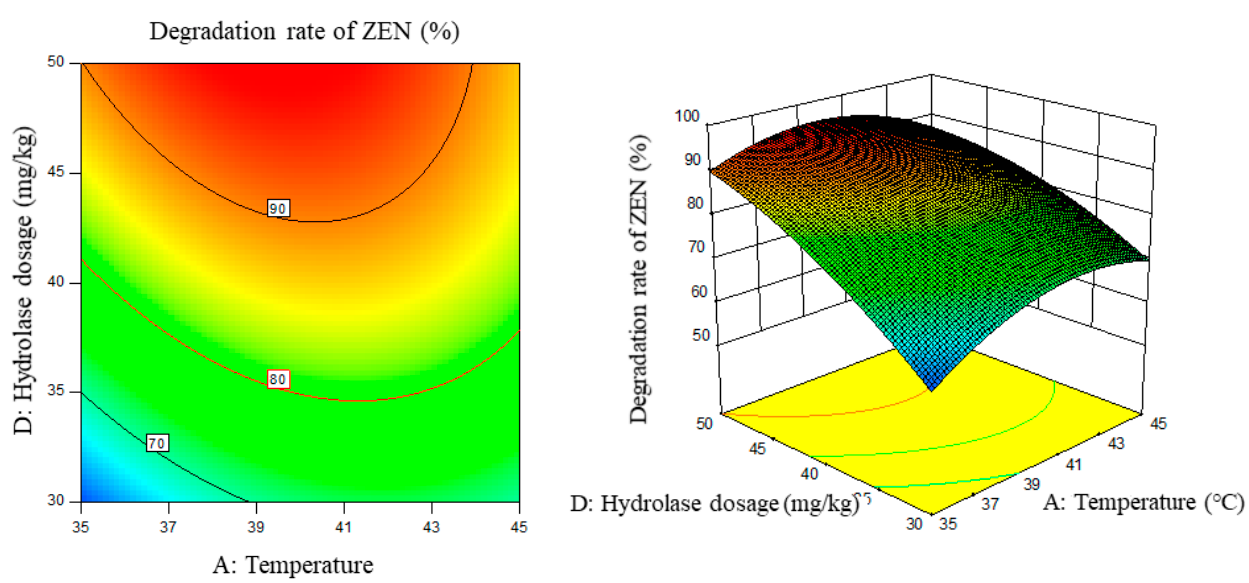
Figure 7. Temperature, enzyme dosage, and their interaction vs. the response surface and contour line of the degradation rate of ZEN.